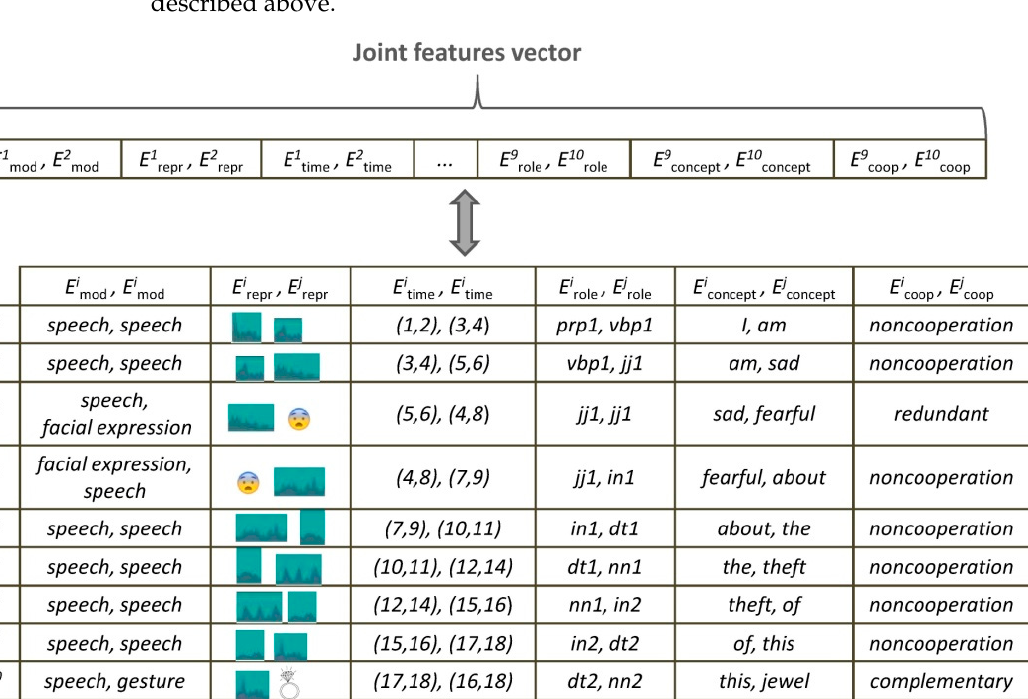
Figure 3. Process of building the joint features vector.